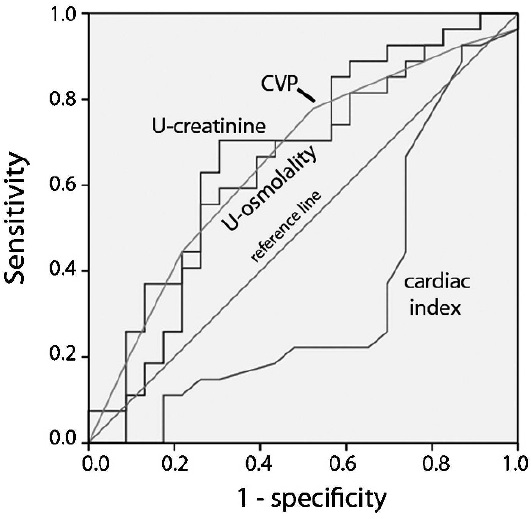
Figure 5 - ROC curves for urinary creatinine concentration, urinary osmolality, central venous pressure (CVP) and cardiac index measured before induction of general anesthesia were used to predict whether patients would later have to receive several starch boluses before becoming volume optimized (i.e., at least two boluses increased their stroke volume by $ 10%). The cardiac index is below the reference line, as low values imply a